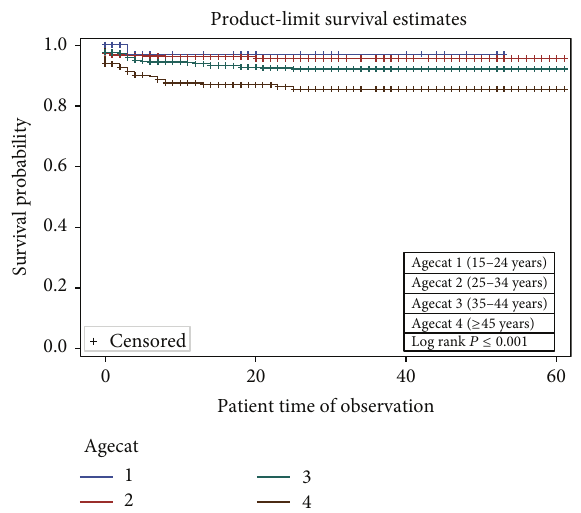
Figure 4: Survival curves based on baseline CD4 staging among patients in